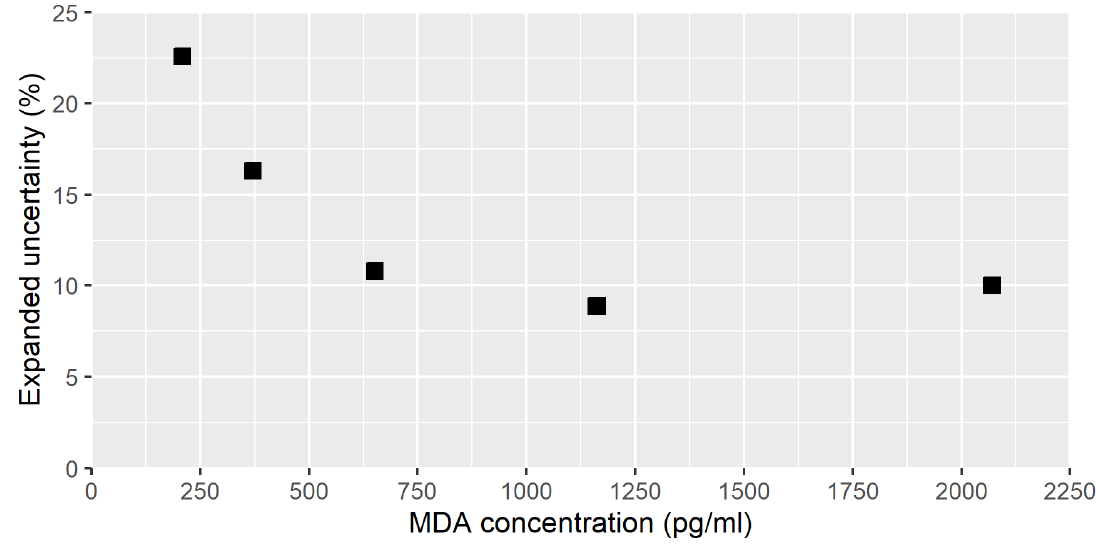
Figure 4. The calculated expanded uncertainty, using a coverage factor of 2, as a function of the MDA concentration in EBC.